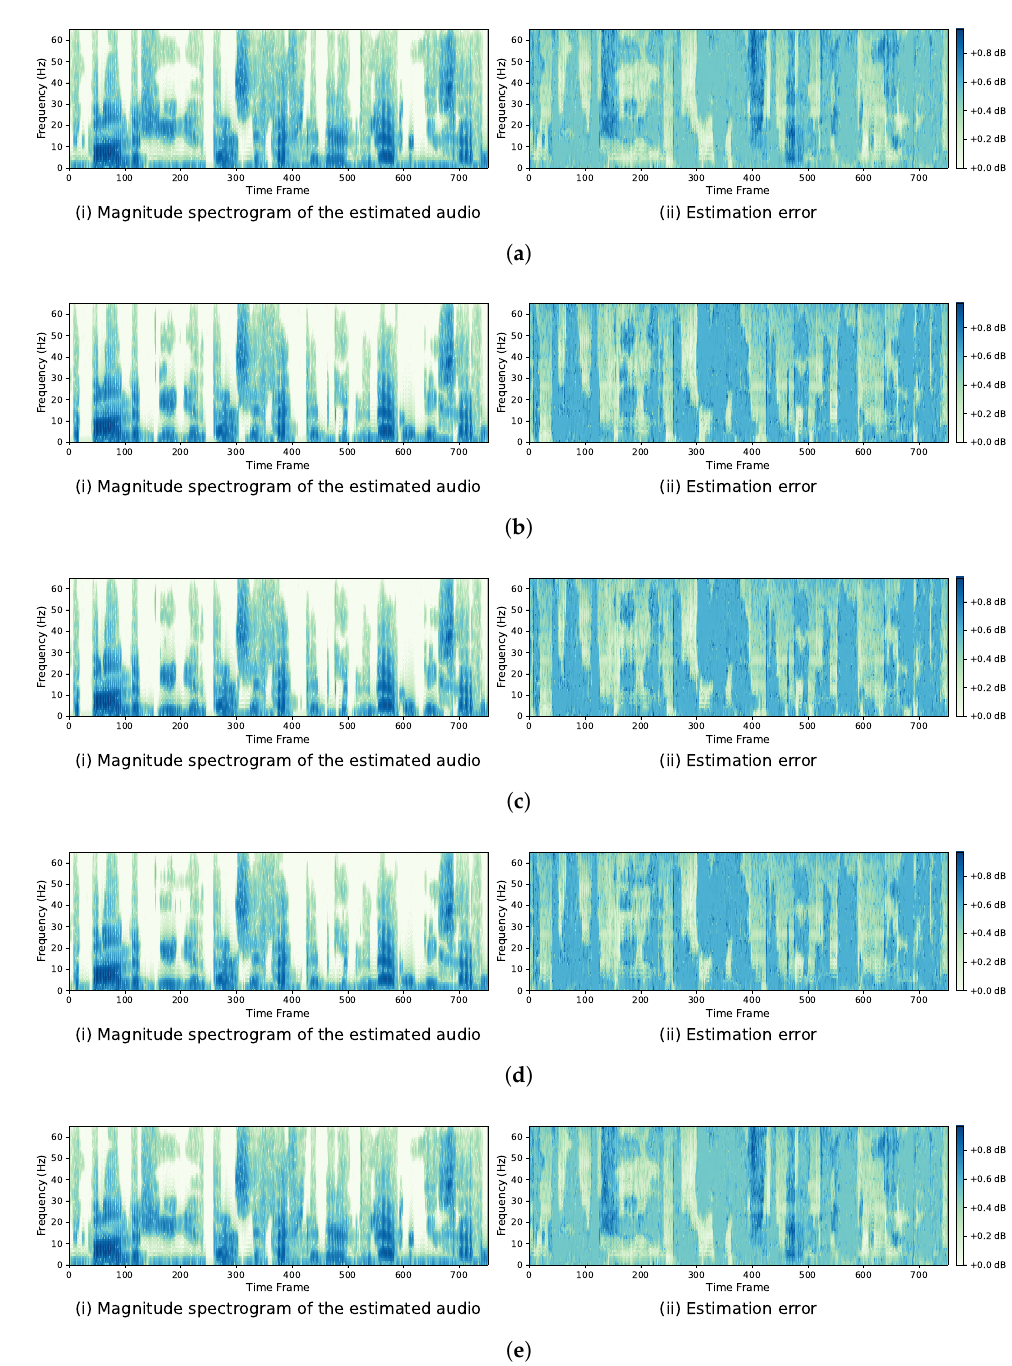
Figure 3. The estimated spectrograms and estimation error diagrams of DPCL model. The x -axis represents the time frame, the y -axis represents the frequency, and the unit of color scale is dB. ( a ) The estimated magnitude spectrogram (i) and the estimation error (ii) of the DPCL model without voiceprint feature integration. ( b ) The estimated magnitude spectrogram (i) and the estimation error (ii) of the DPCL model integrating MFCCs features using DC fusion method. ( c ) The estimated magnitude spectrogram (i) and the estimation error (ii) of the DPCL model integrating MFCCs features using ECC fusion method. ( d ) The estimated magnitude spectrogram (i) and the estimation error (ii) of the DPCL model integrating MFCCs features using CEC fusion method. ( e ) The estimated magnitude spectrogram (i) and the estimation error (ii) of the DPCL model integrating d-vector features using ECC fusion